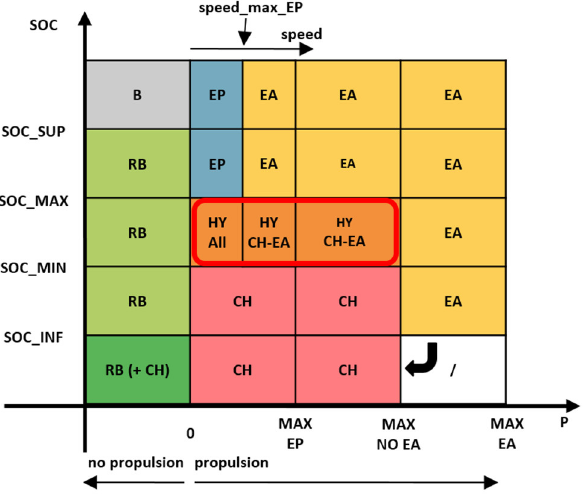
Figure 6. Supervisor logic